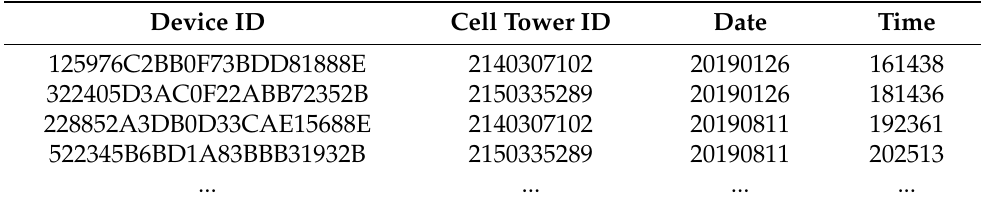
Figure 3. Workflow used by Nommon Solutions to process mobile data. Table 3. Examples of mobile operator’s anonymised